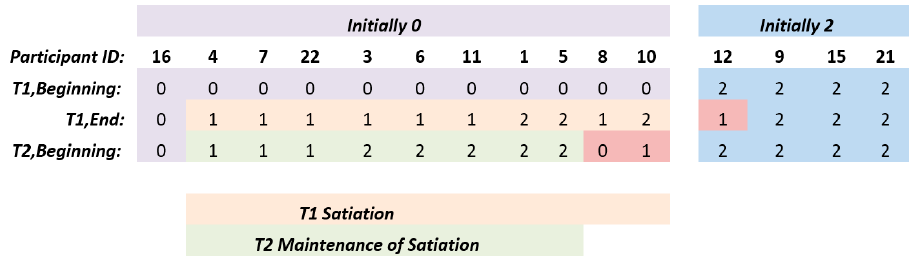
Figure 6. By-participant findings in Experiment II, showing the number (0–2) of Whether-Island violations accepted at three time points (Beginning and End of Experiment I and Beginning of Experiment II).